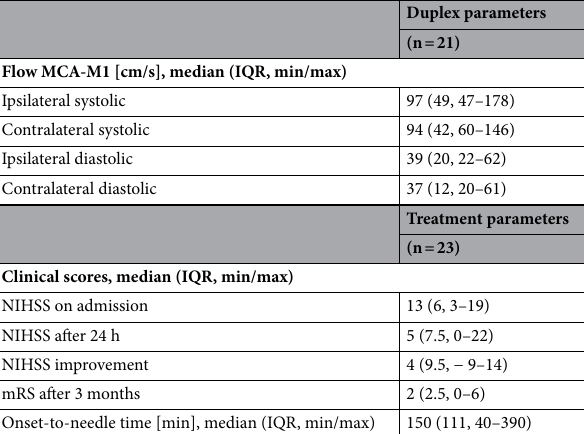
Table 2. Treatment and outcome characteristics. Treatment and Outcome characteristics. In order to assess the reestablished blood flow, the ipsilateral and contralateral MCA-M1 were examined using duplex sonography. In 2/23 cases duplex sonography examination was not possible. Median, interquartile range ( IQR ), minimum and maximum are shown.